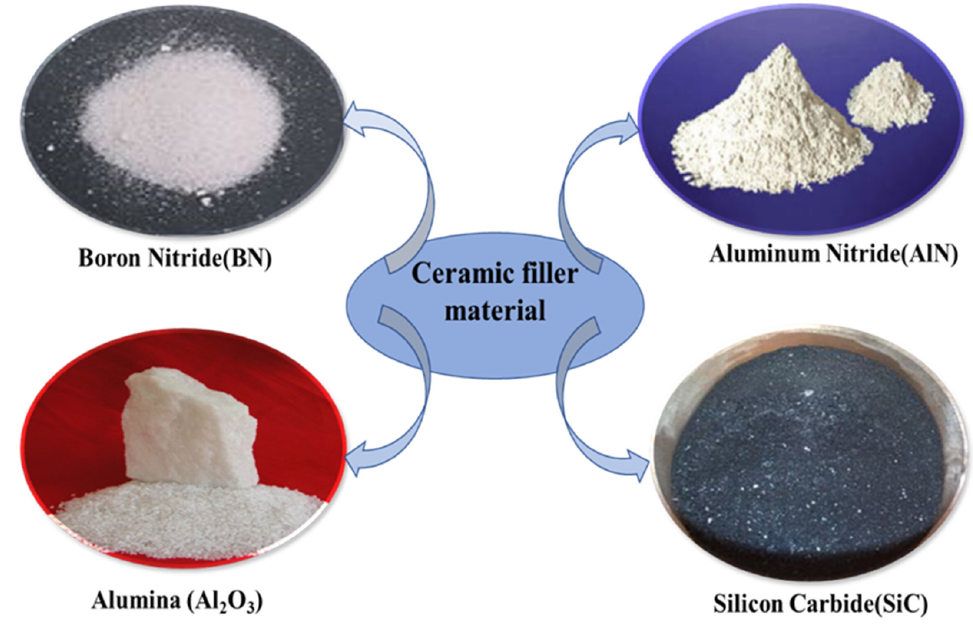
Figure 5. Commonly used thermally conductive ceramics filler.